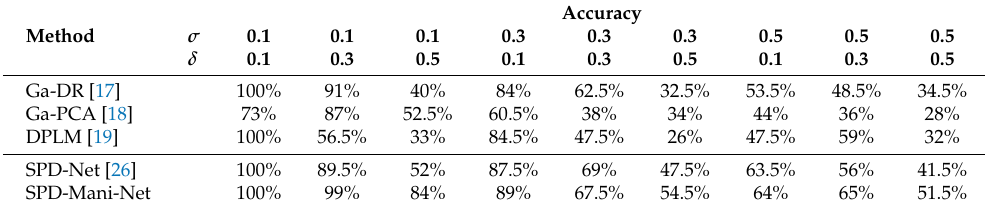
Table 1. Recognition accuracy for toy data.